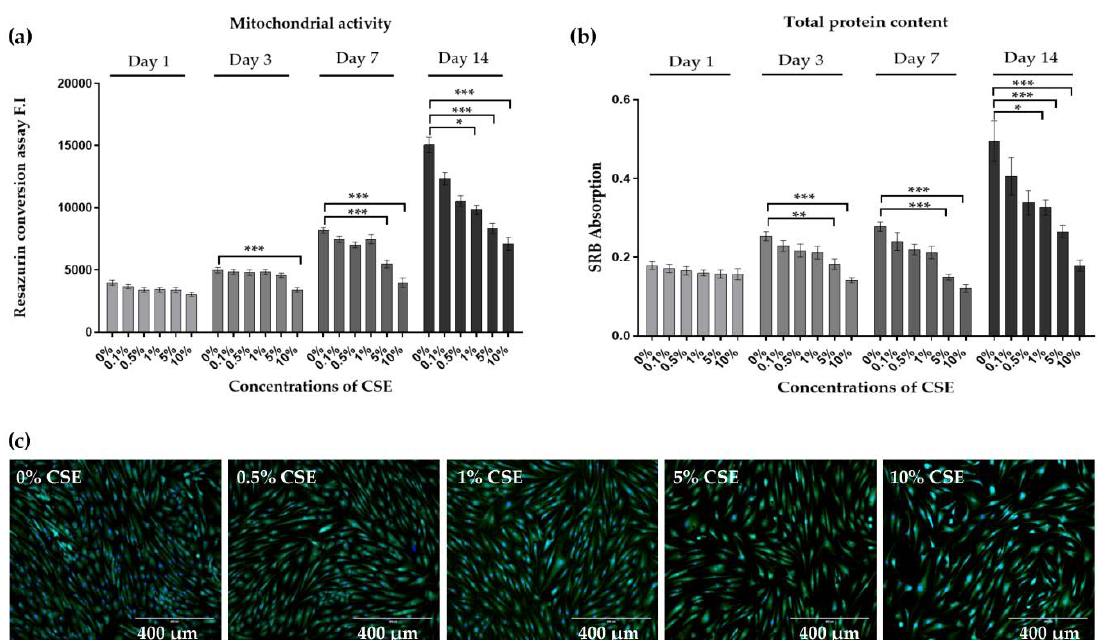
Figure 1. Cigarette smoke extract (CSE) exposure inhibited the viability and proliferation of primary human chondrocytes. Cells ( N = 3, n = 3) were cultured in medium containing 0%, 0.1%, 0.5%, 1%, 5%, and 10% CSE. On day 1, 3, 7, and 14 chondrocytes ( a ) mitochondrial activity was determined by Resazurin conversion and ( b ) total protein content was determined by sulforhodamine B (SRB) staining, respectively. ( c ) Calcein-AM (green) and Hoechst 33,342 (blue) were used to show living cells on day 7, respectively. Results are presented as mean ± SEM. * p < 0.05, ** p < 0.01, *** p < 0.001 as compared to untreated controls.